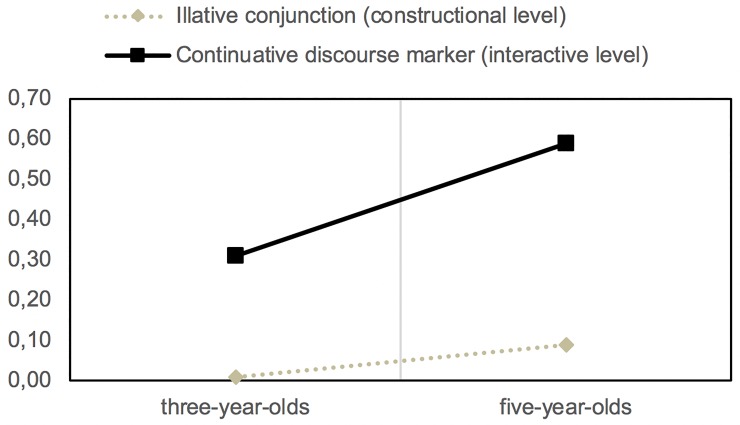
Development of the expression of illation/continuity on the constructional and interactional planes from 3 to 5 years of age.